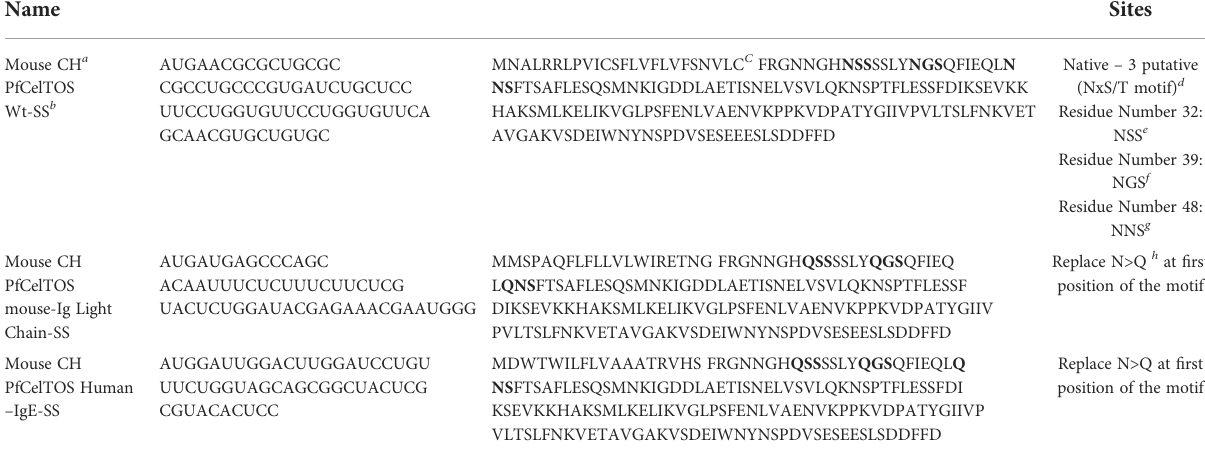
TABLE 1 pfceltos mRNAs translation